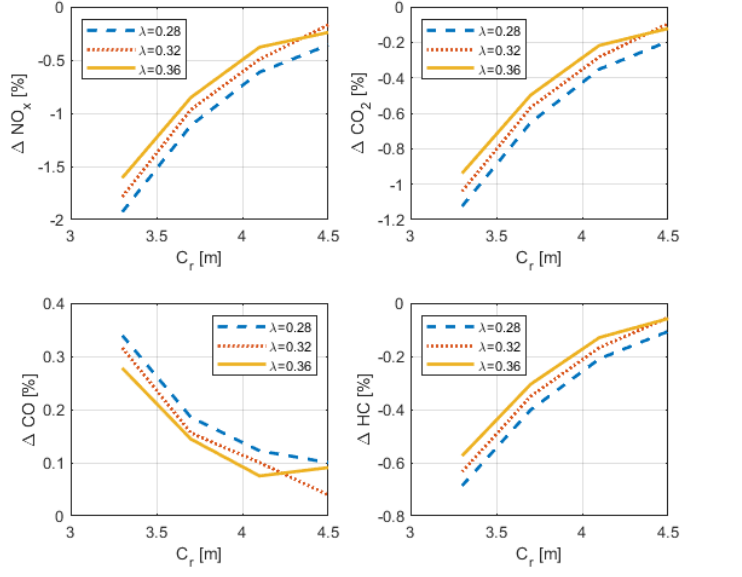
Figure 9. Emissions variation with respect to the reference aircraft for the design route as a function of the taper ratio and root chord along the new feasible design space determined by intersecting the active